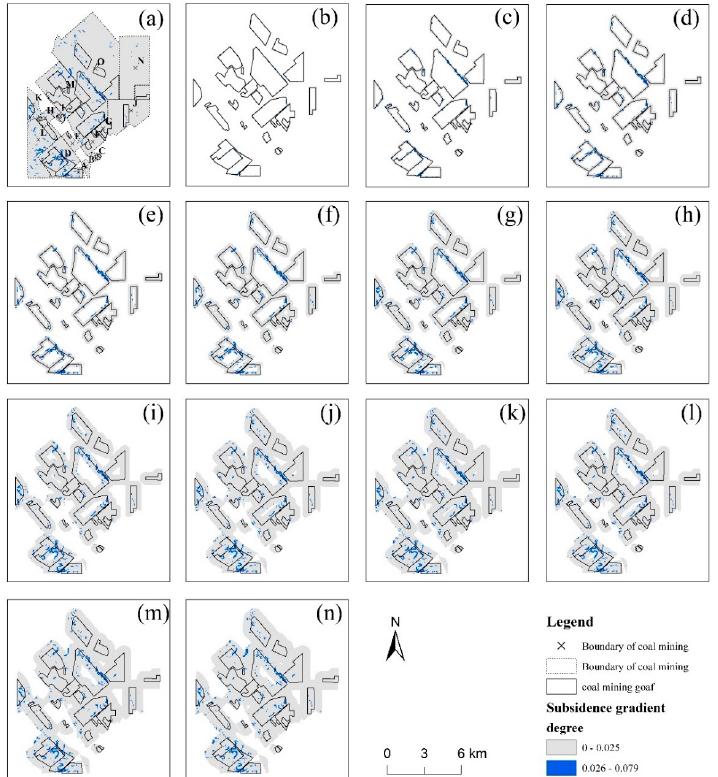
Figure 7. ( a ) Subsidence gradient in the entire coal mining area; ( b to n) Subsidence gradient map with buffers along the goafs boundary ranging from 50 m to 650 m with an interval of 50 m; The blue pixels represent the high subsidence gradient.